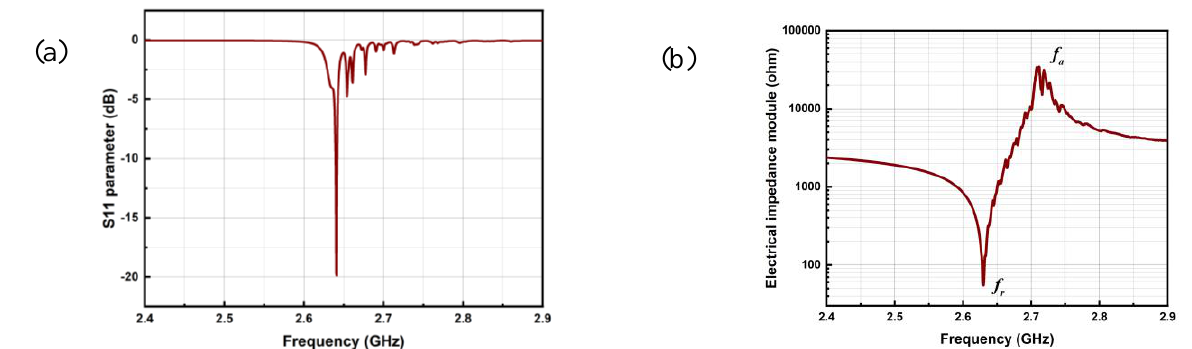
Figure 8. (a) 𝑆 11 parameter and (b) electrical impedance of a 2.63 GHz ZnO based SMR (simulation 261 Figure 8. ( a ) S 11 parameter and ( b ) electrical impedance of a 2.63 GHz ZnO based SMR (simulation results). 262